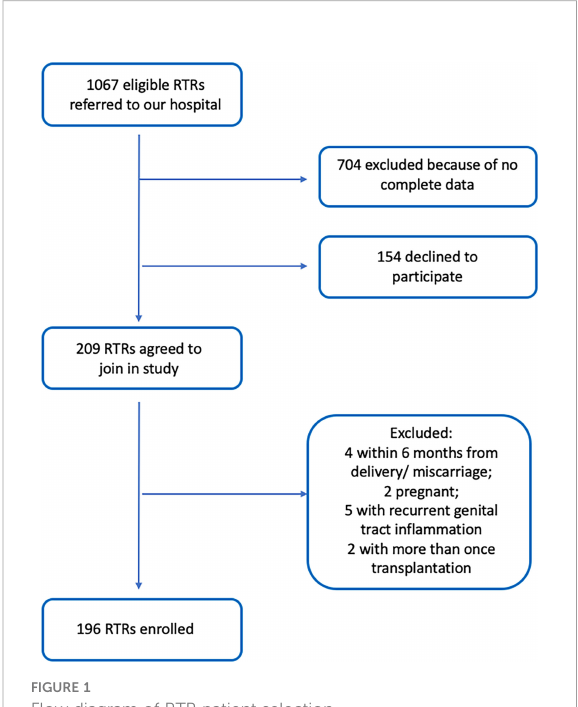
FIGURE 1 Flow diagram of RTR patient